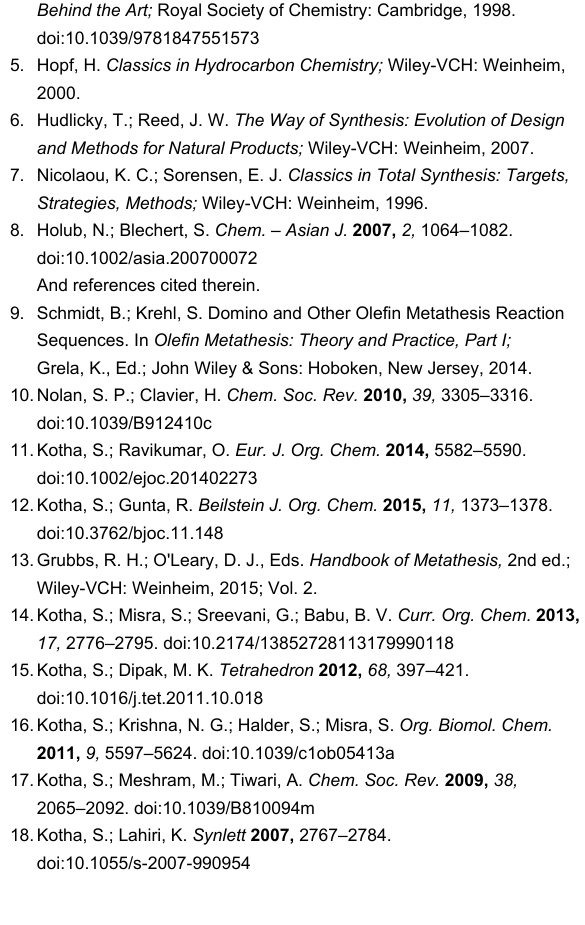
for diversity-oriented synthesis [37] by employing